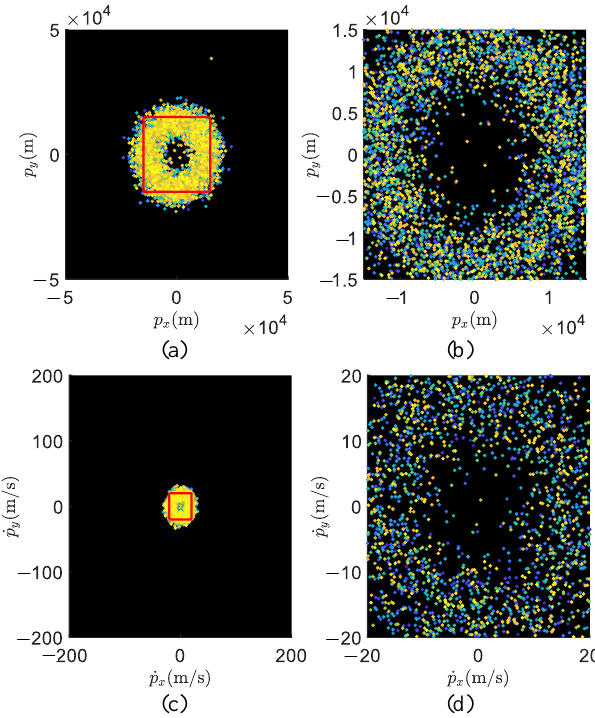
Figure 4. Results of the CAR method: ( a , b ) sample positions; ( c , d ) sample velocities.